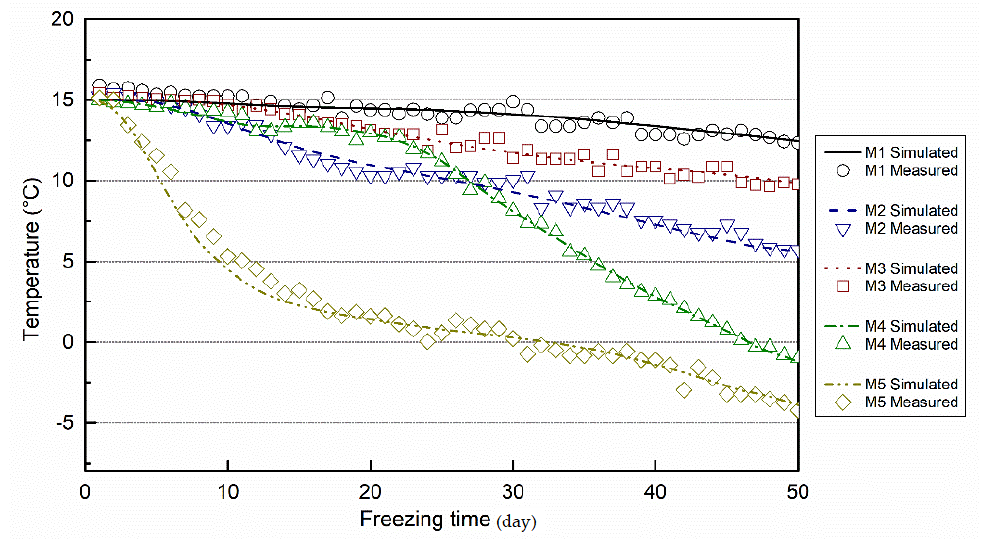
Figure 12. The temperature comparison curve of monitoring points between simulated and measured